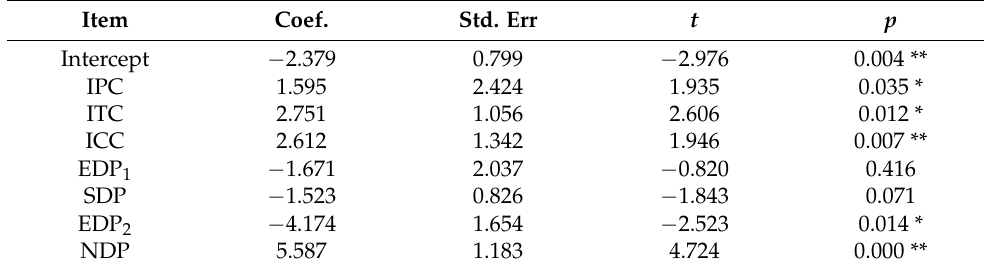
Table 7. Regression results of factors related to the security.